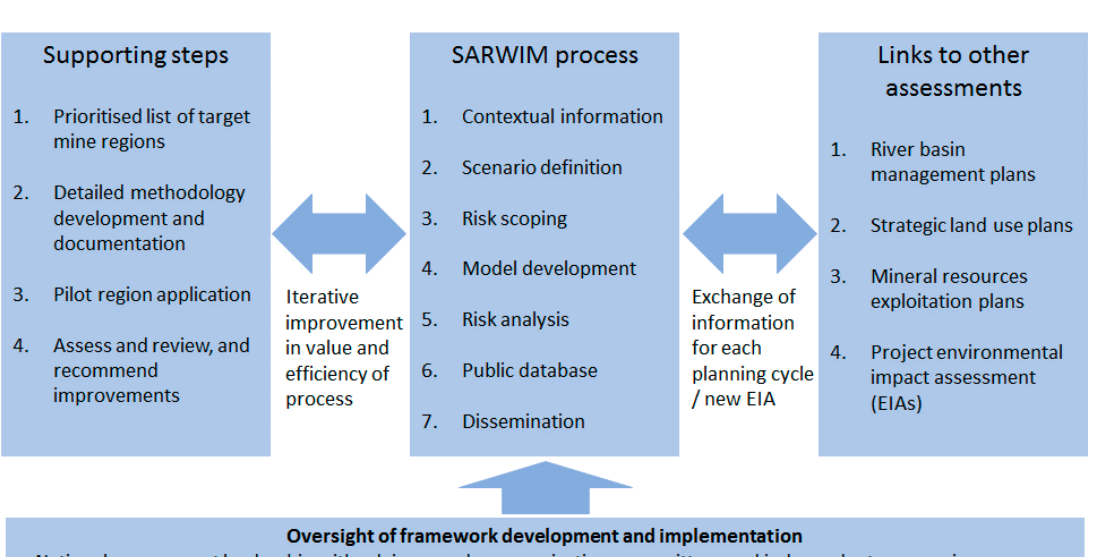
Figure 2. Outline of the proposed framework for Strategic Assessment of Regional Water Impacts of Mining (SARWIM).